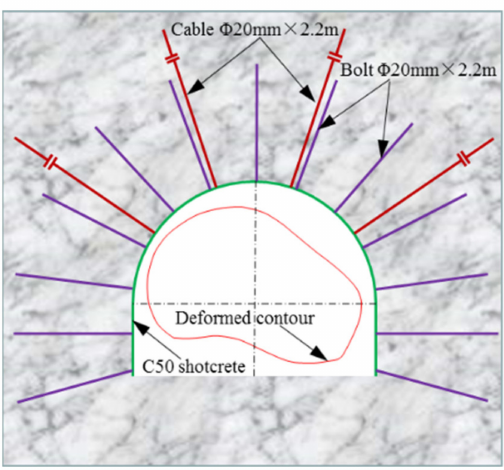
Figure 7. Support pattern and final failure characteristics of roadway surrounding